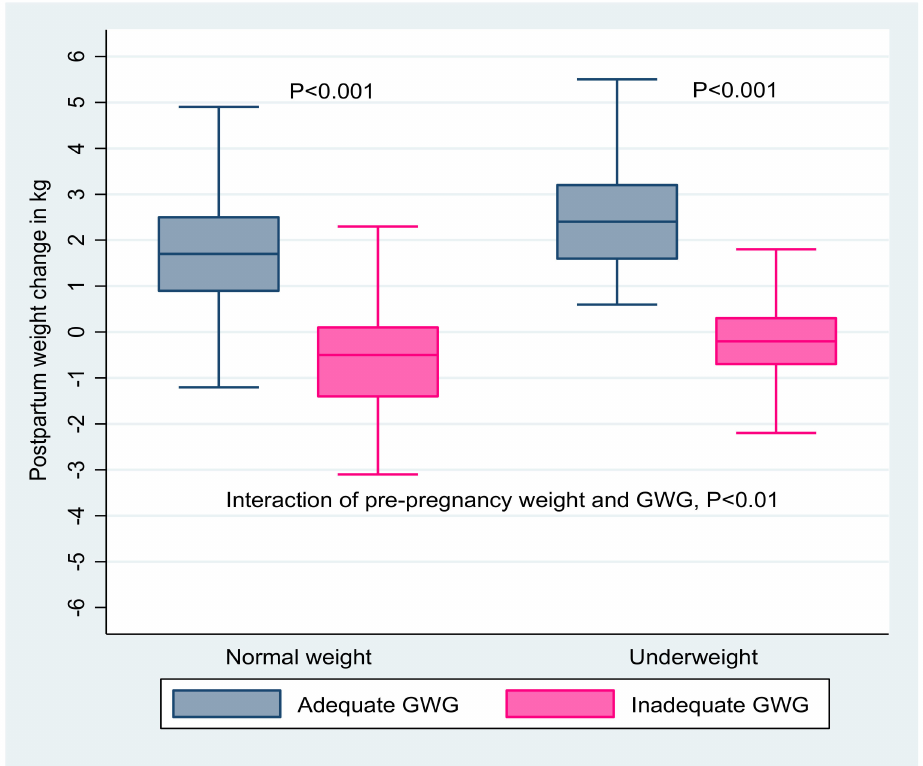
Figure 2. Postpartum weight change in kg separated by pre-pregnancy BMI (left panel: normal weight: BMI 18 to 25; right panel: underweight: BMI < 18.5) and gestational weight gain (GWG, adequate in blue, inadequate in pink) in Tigray region, northern Ethiopia, 2018. p -values indicate comparisons of adequate versus inadequate GWG among normal weight and underweight